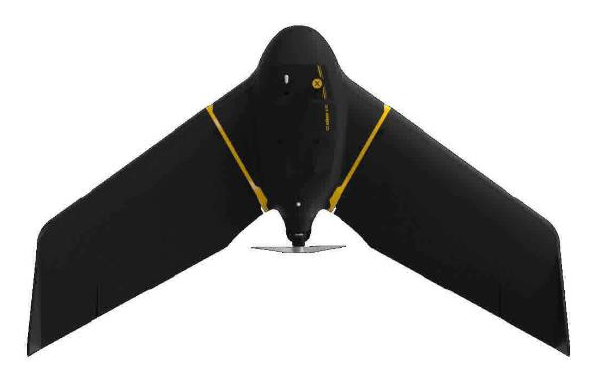
Figure4. Sensefly eBee X fixed-wing drone